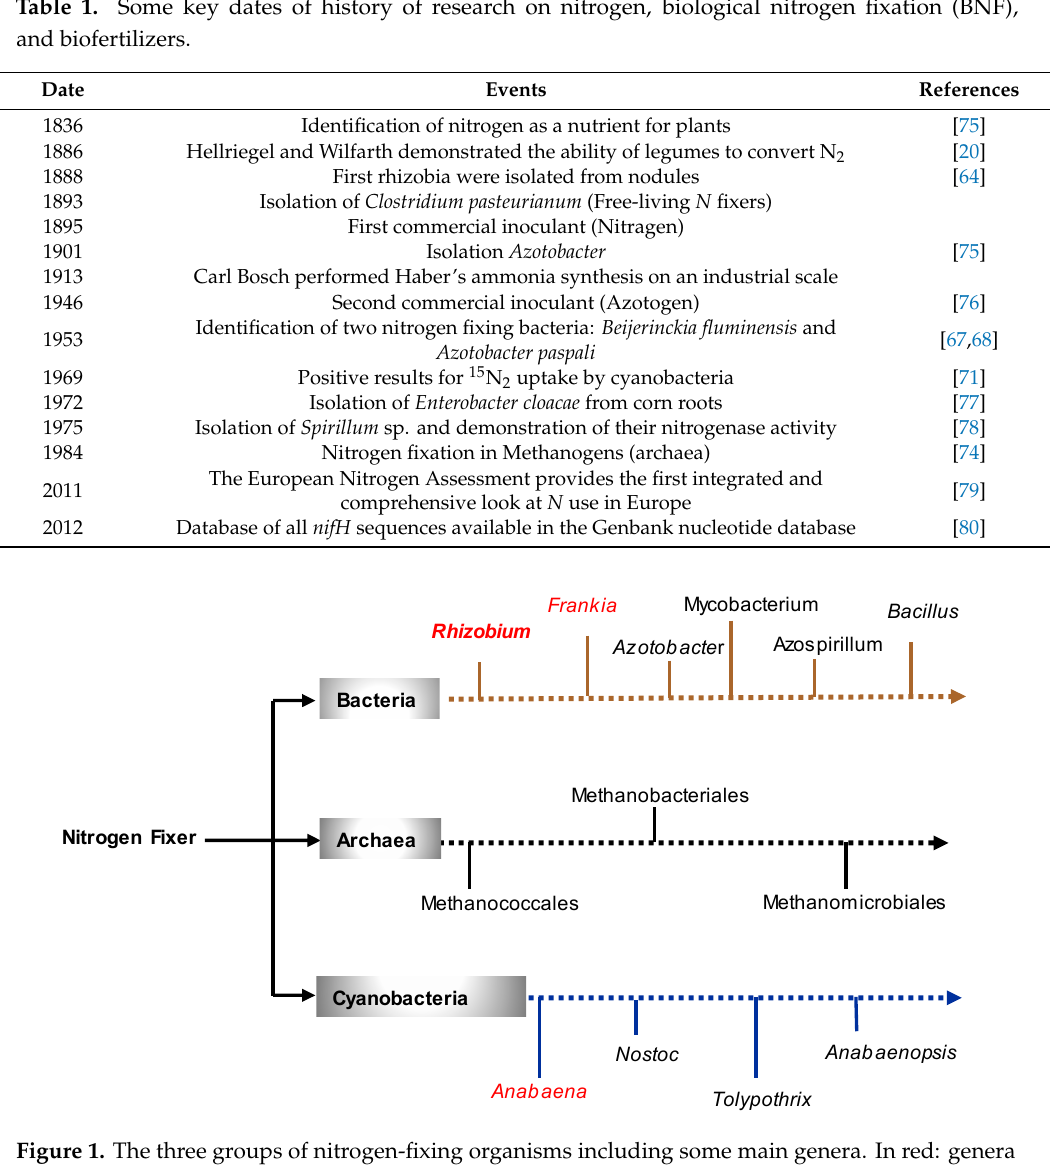
Figure 1. The three groups of nitrogen-fixing organisms including some main genera. In red: genera including symbiotic nitrogen-fixing species; in black: orders or genera (in italics) including free living nitrogen-fixing species.